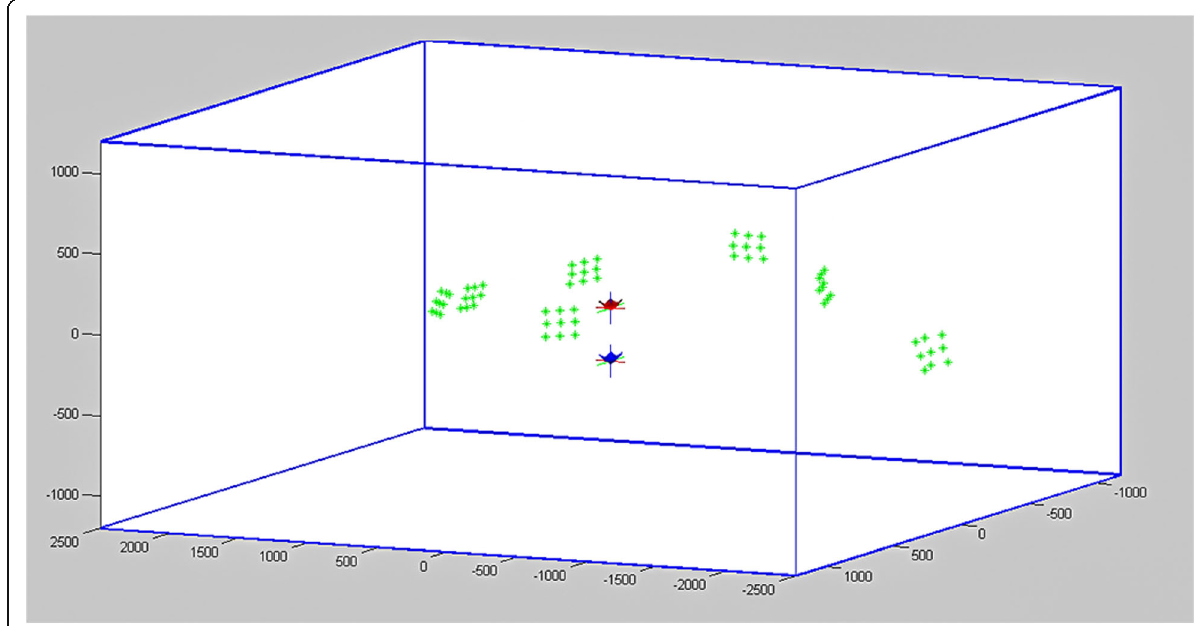
Fig. 13 The 3D positive view of the 3D reconstruction of the seven calibration boards in Fig. 11b left . The origin is the middle of the sensor (the upper camera is shown in red , and the lower camera is shown in blue ). The coordinates of all matching points can be extracted from the generated